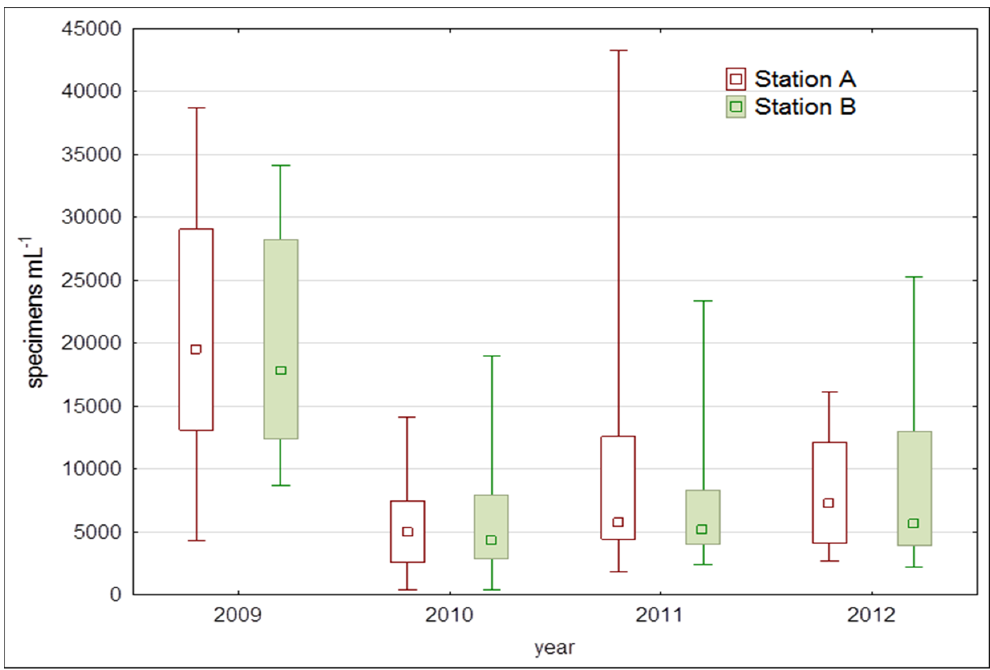
Figure 8. Mean values of phytoplankton abundance, standard deviation and min ‐ max at both stations.